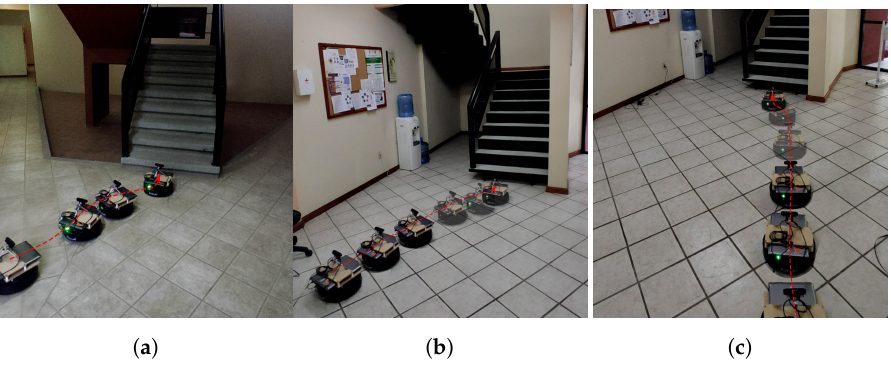
Figure 11. Staircase approach and alignment paths obtained using Fuzzy Logic: ( a ) positioned to the left of staircase 1, ( b ) robot positioned to the left of staircase 2, ( c ) robot positioned to the right of staircase